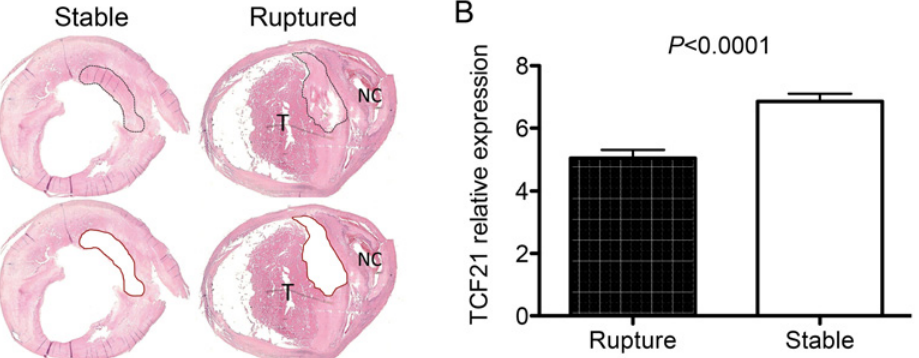
Fig 8. Differential TCF21 gene expression in fibrous cap of stable vs. ruptured atherosclerotic plaque. A) Microdissection laser capture was employed to harvest tissue from endarterectomy samples from vessels with stable plaque or evidence of plaque rupture. An example of a stable plaque and a ruptured plaque with necrotic core (NC) and related luminal thrombus (T) are shown. These representative sections show the types of plaque regions that were harvested for RNA isolation. B) qPCR quantitation of TCF21 mRNA levels in harvested tissue. TCF21 expression was significantly lower in fibrous cap tissue from the ruptured